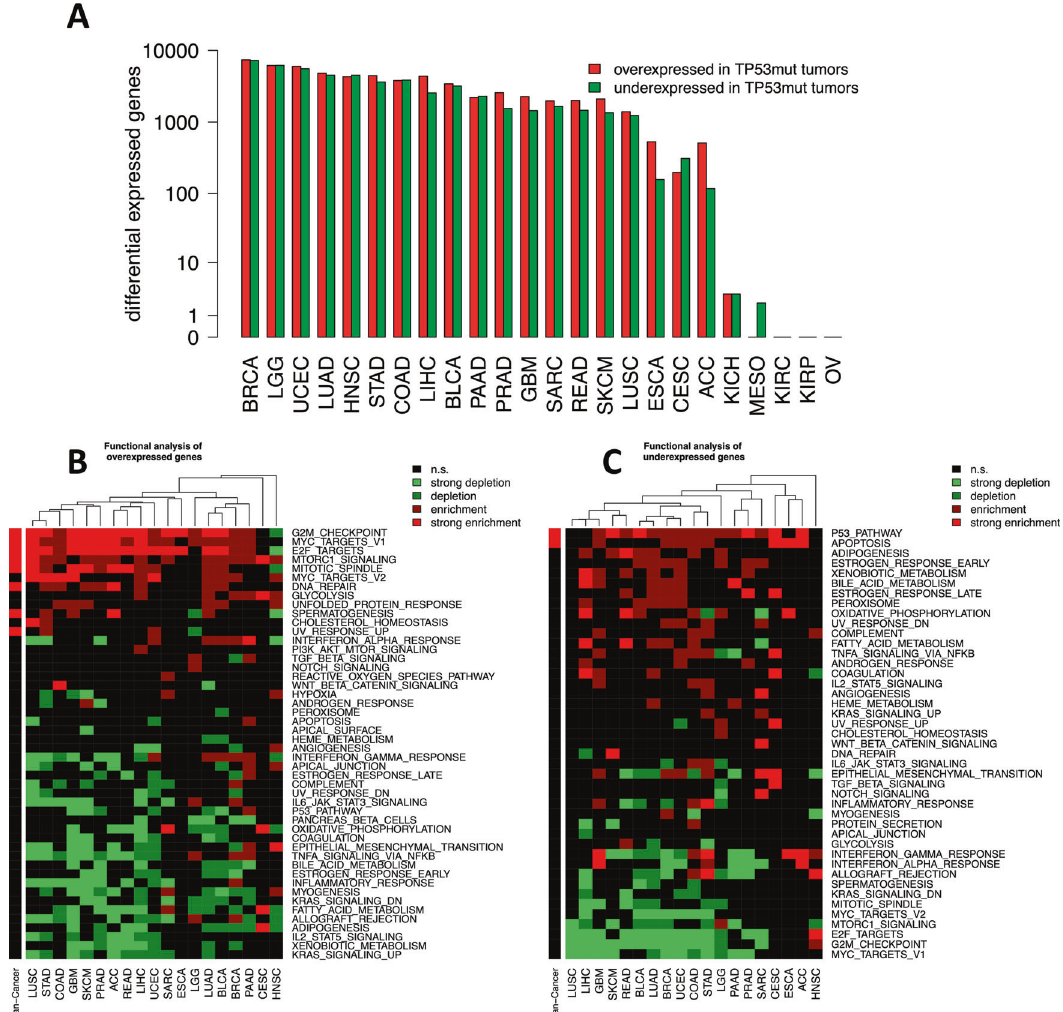
Fig. 4 Differential gene expression and functional analysis in speci fi c cancer types. A Numbers of signi fi cantly (FDR = 10%) differentially expressed genes between TP53mut and TP53wt tumors for 24 speci fi c cancer types. B Signi fi cantly enriched categories of the hallmark catalog in the set of overexpressed genes. C Same as B , but for the set of underexpressed genes. Signi fi cantly enriched or depleted gene sets are shown in red or green. Multiple testing correction (FDR = 10%) was performed, including both cancer types and analyzed categories (20 ×50 hypotheses). Enrichment FC = proportion of the genes in the gene set annotated to the hallmark / proportion of the genes in the genome annotated to the